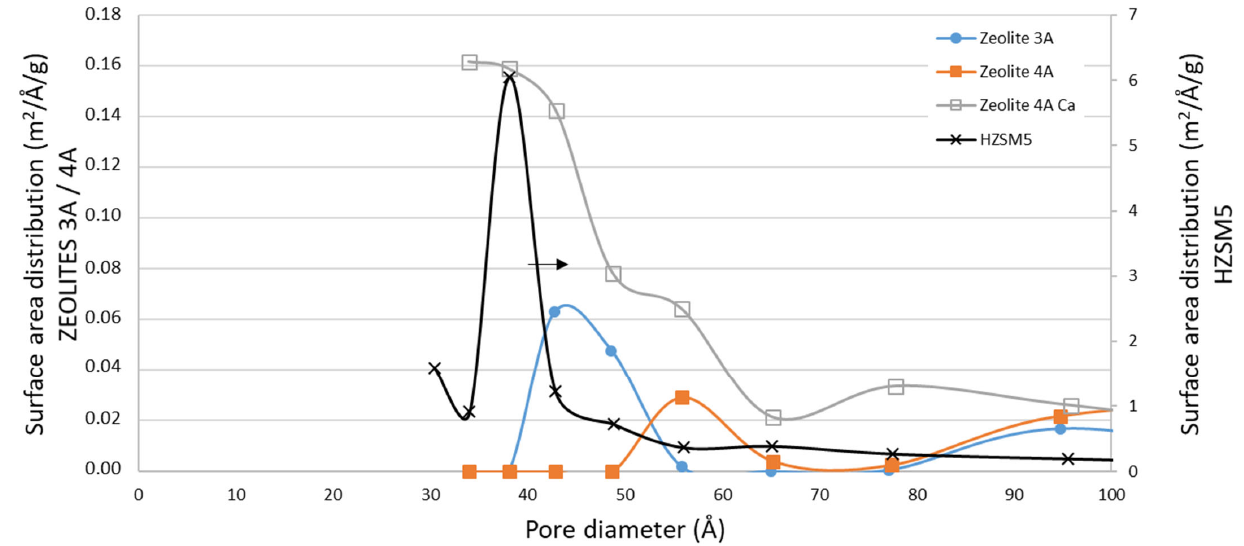
Figure 7. Comparison of the surface area distribution for ZSM5 (right axis), zeolite 3A (left axis), zeolite 4A (left axis) and zeolite 4A Ca (CaCl 2 ) (left axis). Obtained from the N 2 adsorption–desorption isotherm data. (BJH method desorption surface area).